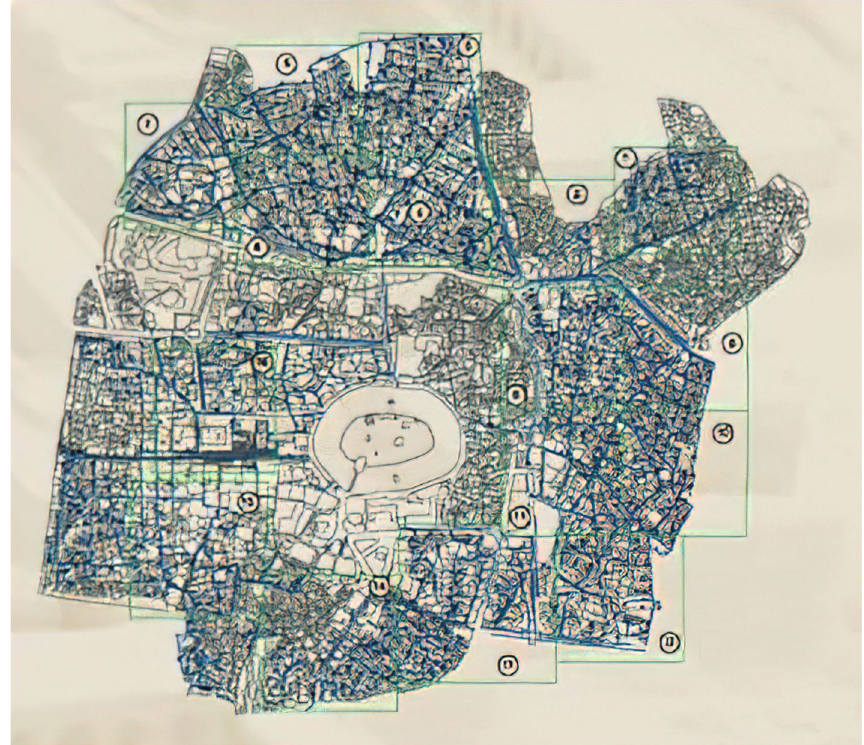
Fig. 11 Map Provided by the GTZ and DOCA on the Renewal of the Sewer and Drinking Water Networks in 2005 (Source: GTZ 2008)